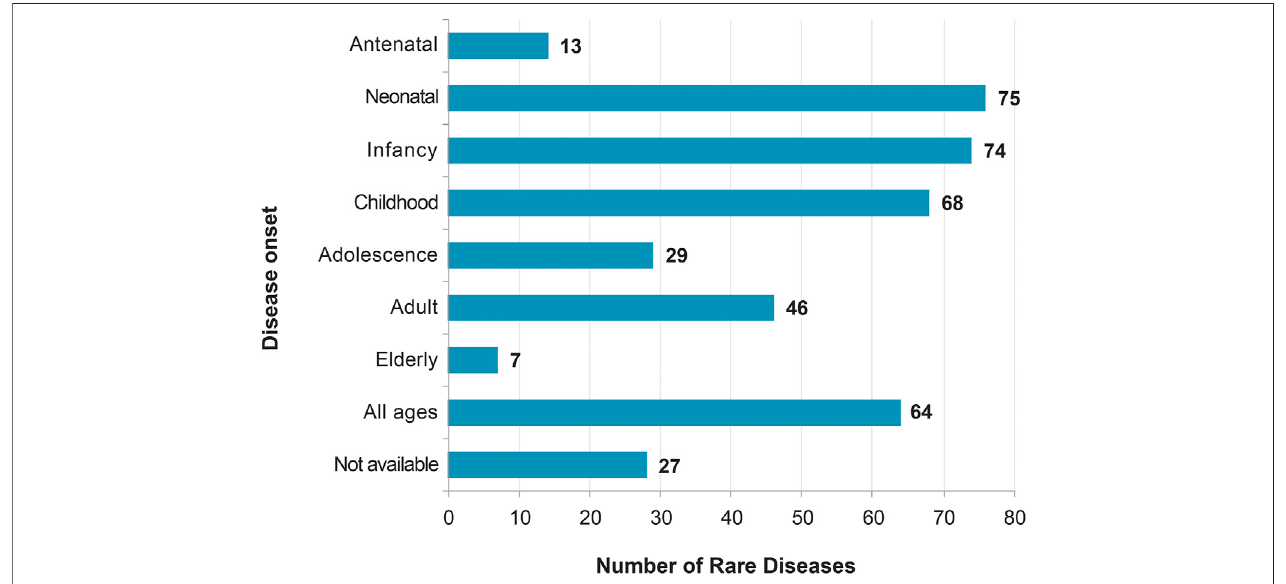
FIGURE 3 | Distribution of the age of onset of the rare diseases for which a delayed diagnosis would be especially detrimental, in the context of the study.